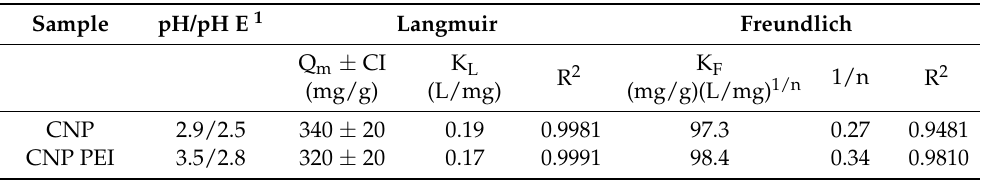
Table 1. pH of the carbon surface and isotherm parameters for Cr (VI) adsorption on CNP and CNP PEI at solution pH of ~ 2.